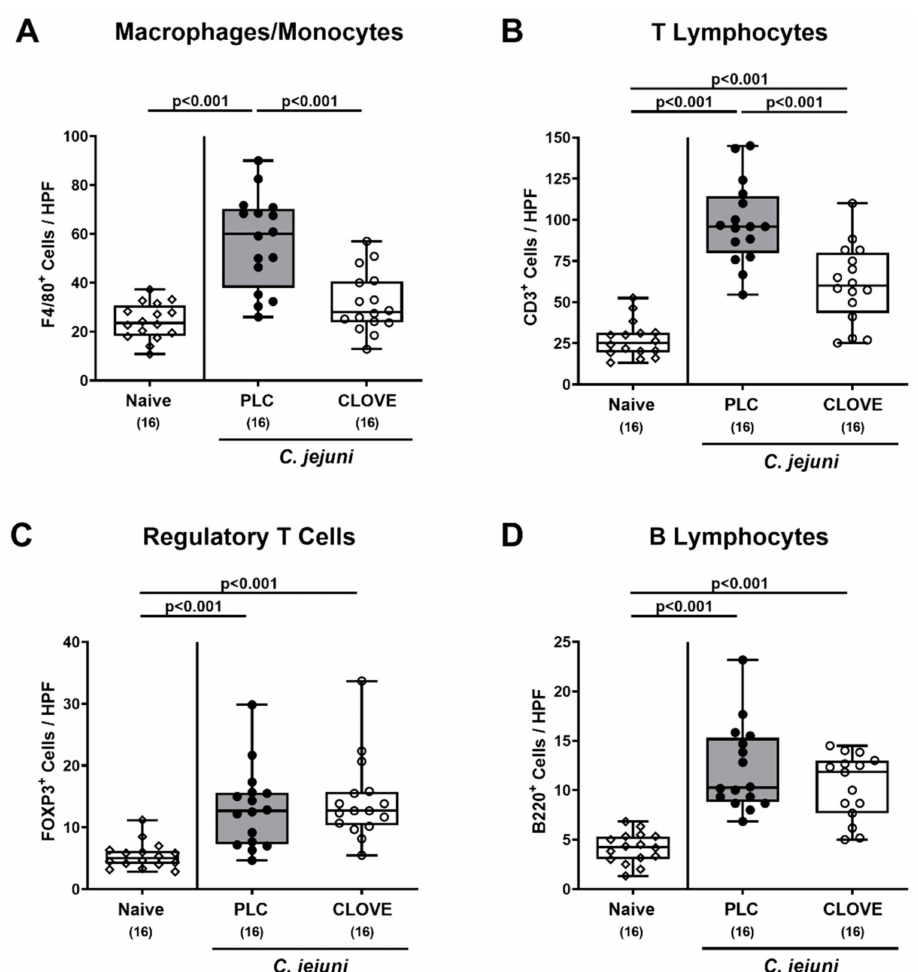
Figure 5. C. jejuni induced immune cell responses following clove EO treatment of infected IL-10 − / − mice. Microbiota- depleted IL-10 − / − mice were perorally infected with C. jejuni strain 81-176 on day (d) 0 and d1. From d2 until d6 post-infection (p.i.), mice were perorally challenged with clove EO or received placebo (PLC) via drinking water. On day 6 p.i., the average numbers of ( A ) macrophages and monocytes (F4/80 + ), ( B ) T lymphocytes (CD3 + ), ( C ) regulatory T cells (FOXP3 + ) and ( D ) B lymphocytes (B220 + ) per animal were determined in immunohistochemically stained colonic paraffin sections from six high power fields (HPF, 400 × magnification). Box plots indicate the 75th and the 25th percentiles of the median (black bar within box). Naive mice were included as negative control animals. The total range, significance levels ( p values) determined by the Kruskal-Wallis test and Dunn’s post-correction and the total numbers of analyzed mice (in parentheses) are given. Data were pooled from four independent